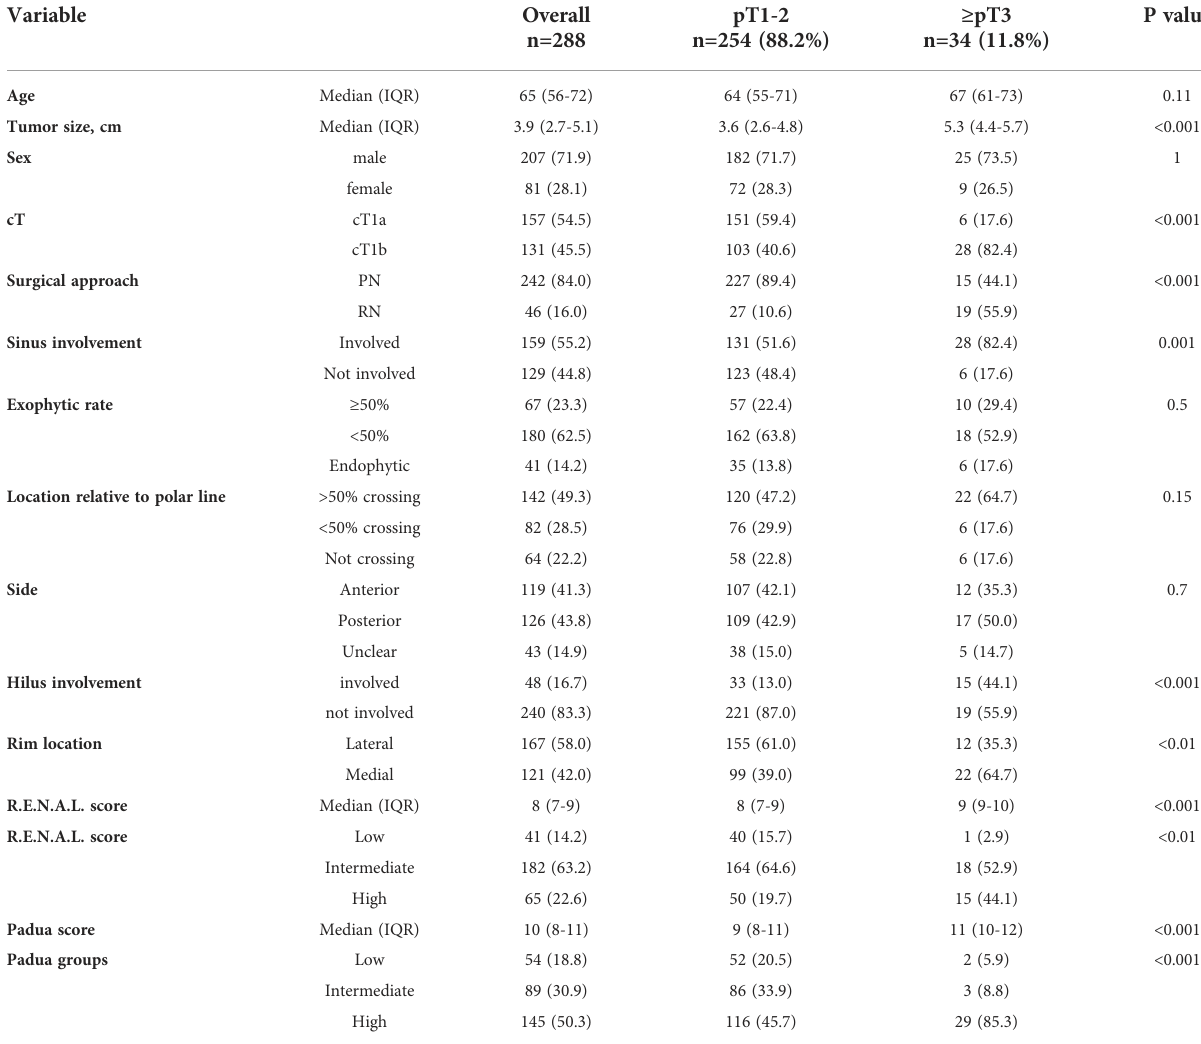
TABLE 1 Descriptive characteristics of 288 clear cell renal cell carcinoma patients, surgically treated between 2008-2021 at the University Hospital Frankfurt, strati fi ed according to pT1-2 vs. ≥ pT3 stage.